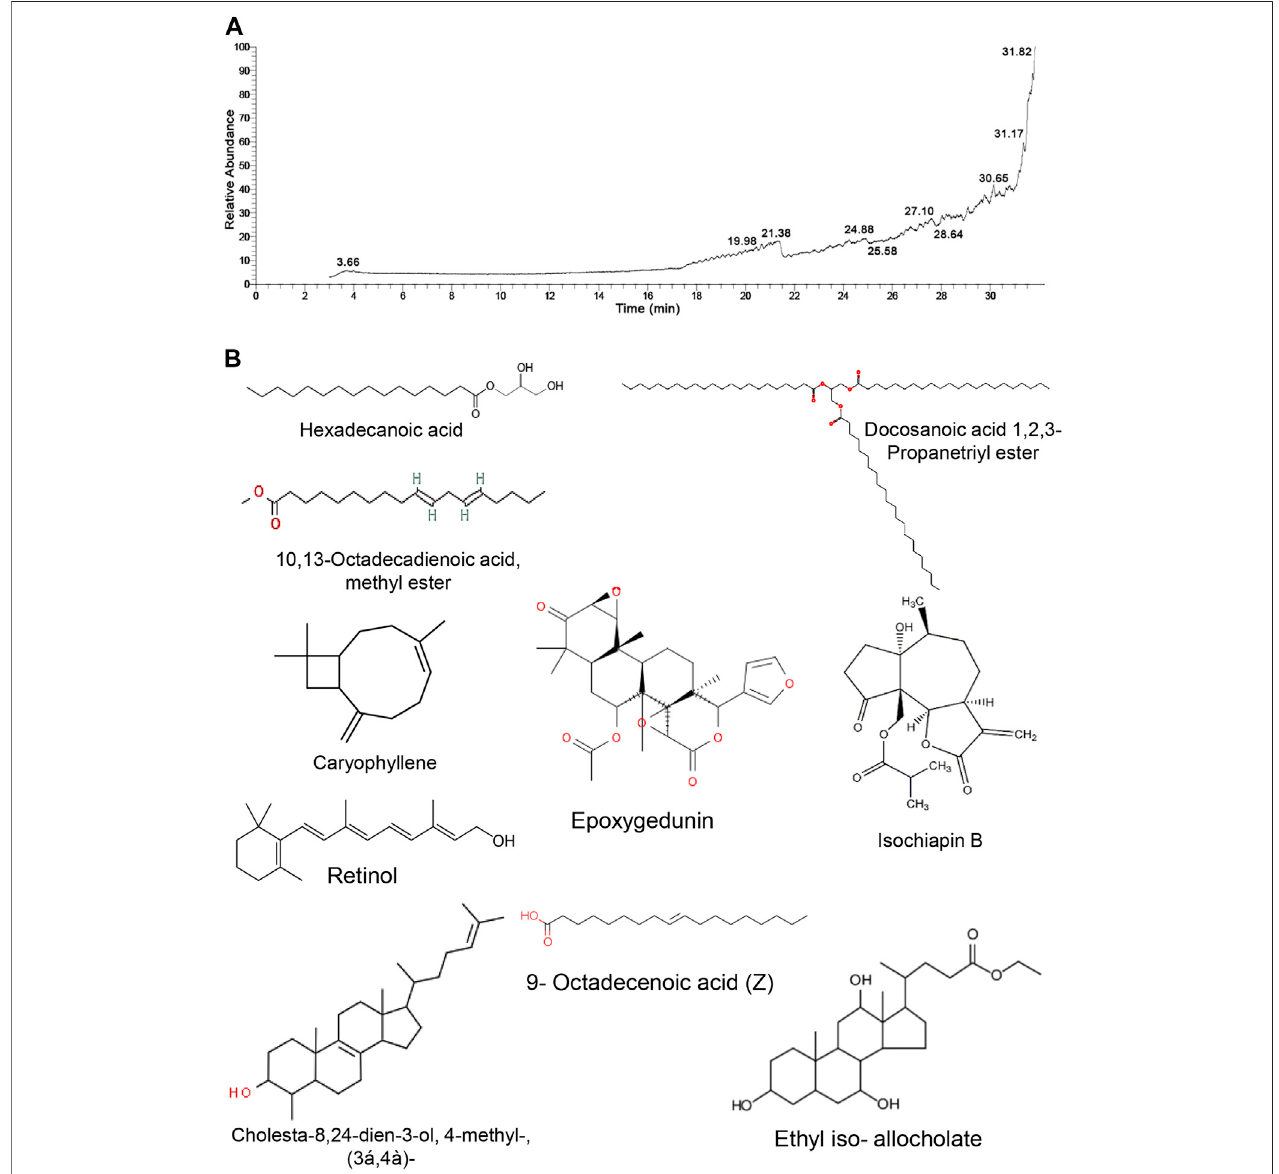
FIGURE 1 | GC/MS analysis of Tamarindus indica seeds extract. (A) GC/MS chromatogram pattern of TM exhibits the abundance of distinct phytochemical constitutes isolated at various retention times. (B) Chemical construction of the identi fi ed phytochemicals.